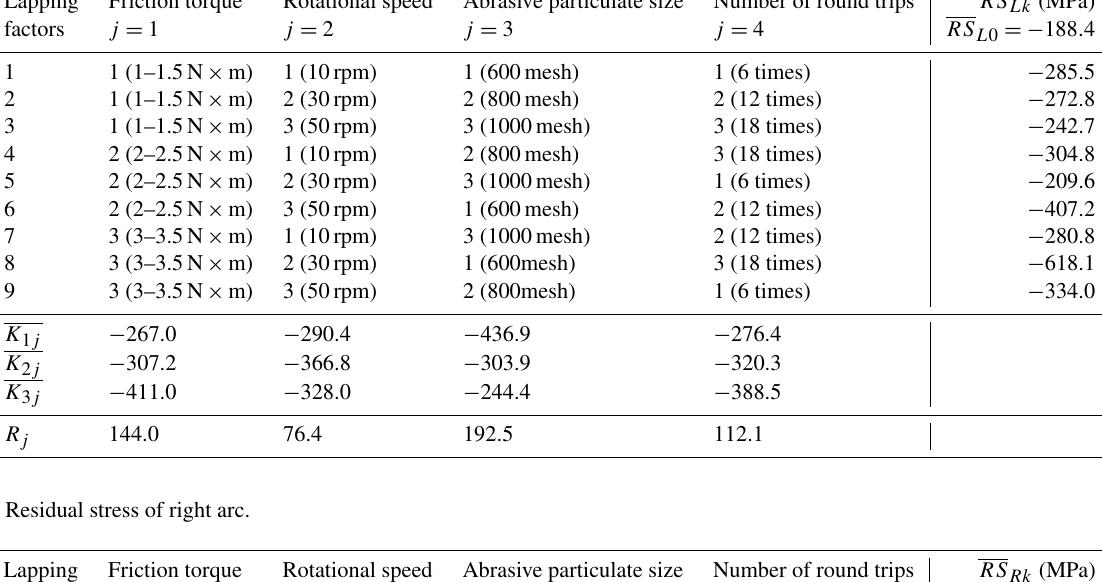
Table 6. Residual stress of left arc. Lapping Friction torque Rotational speed Abrasive particulate size Number of round trips